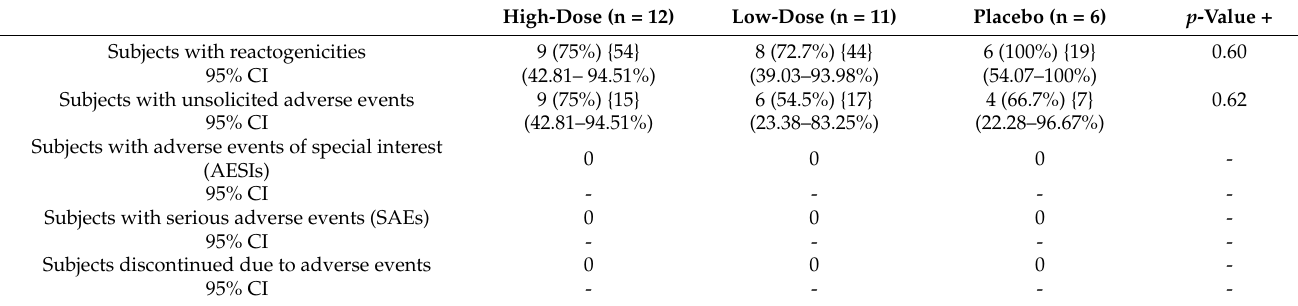
Table 2. Summary of adverse events within 56 days after the first